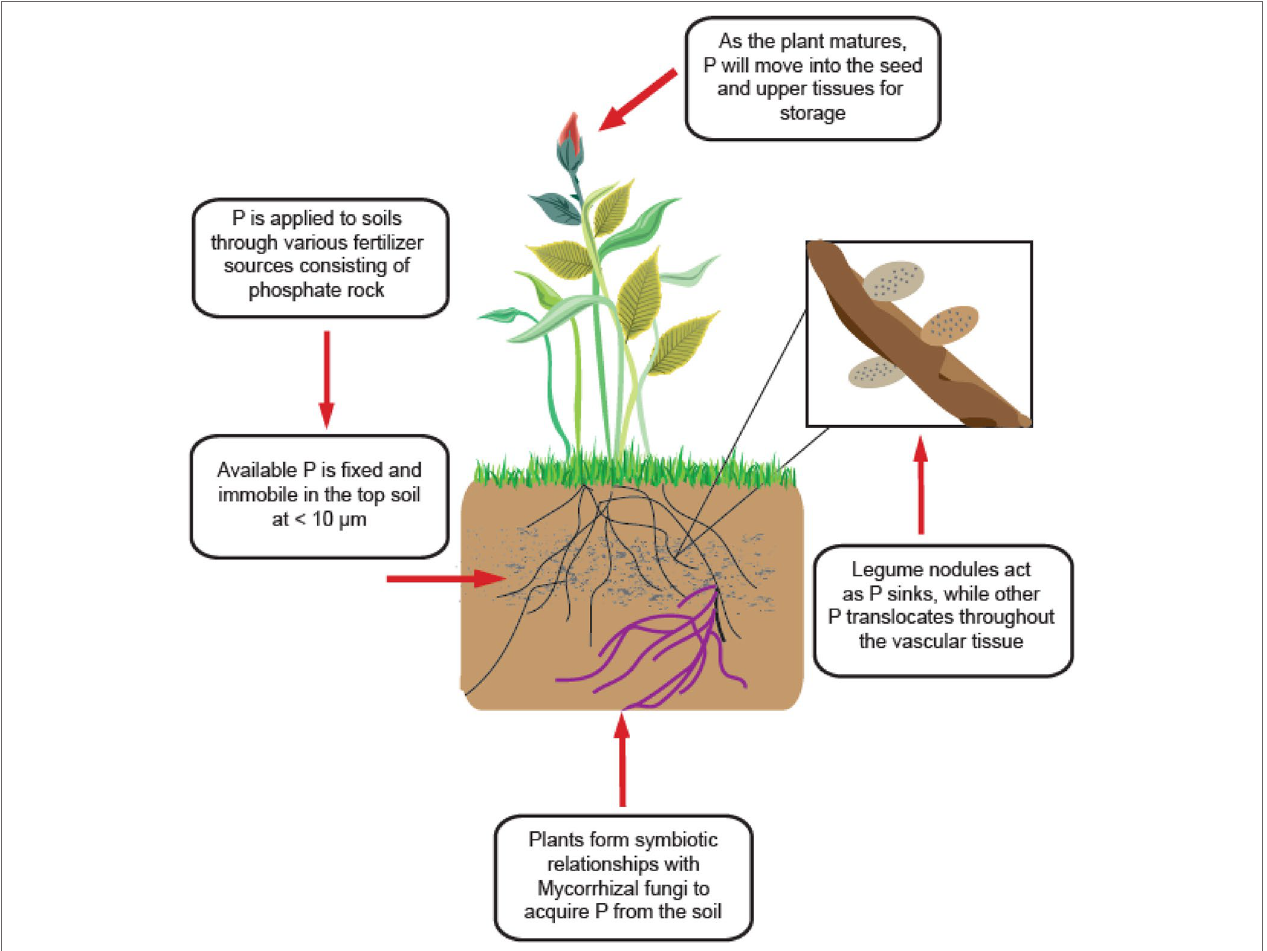
FIGURE 2 | General scheme of P acquisition and utilization of legume